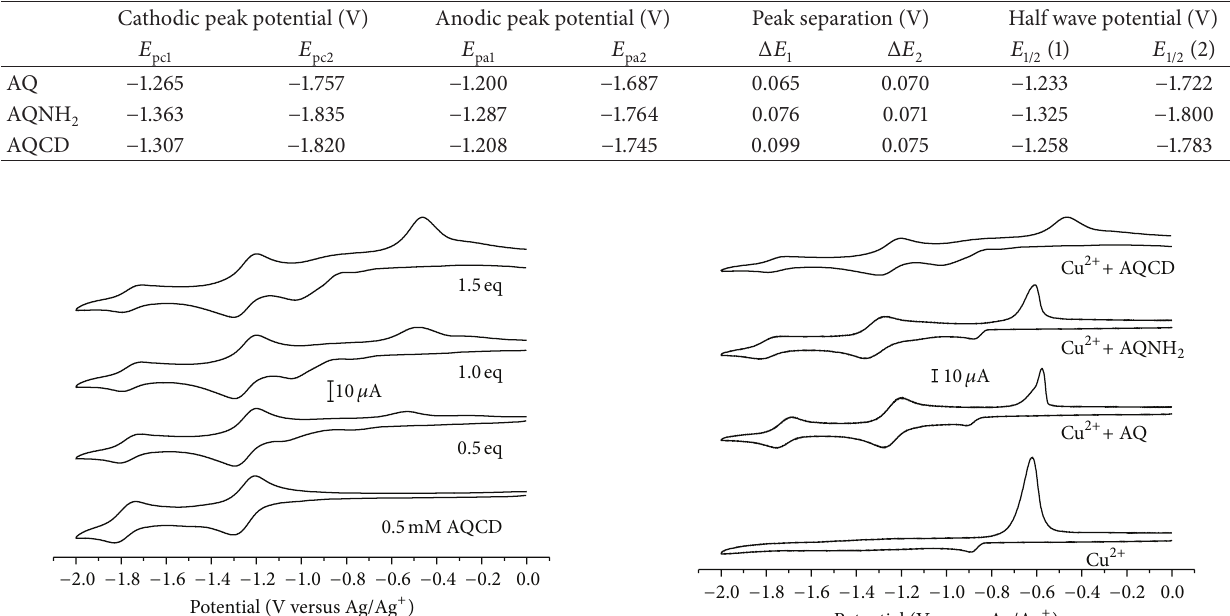
Table 1: The values of 𝐸